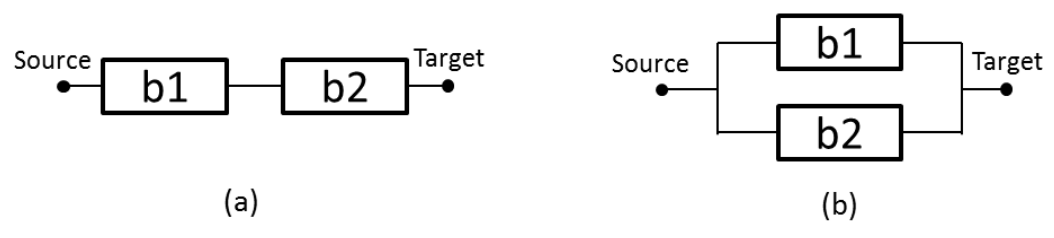
Figure 1. ( a ) Serial arrangement; and ( b ) parallel